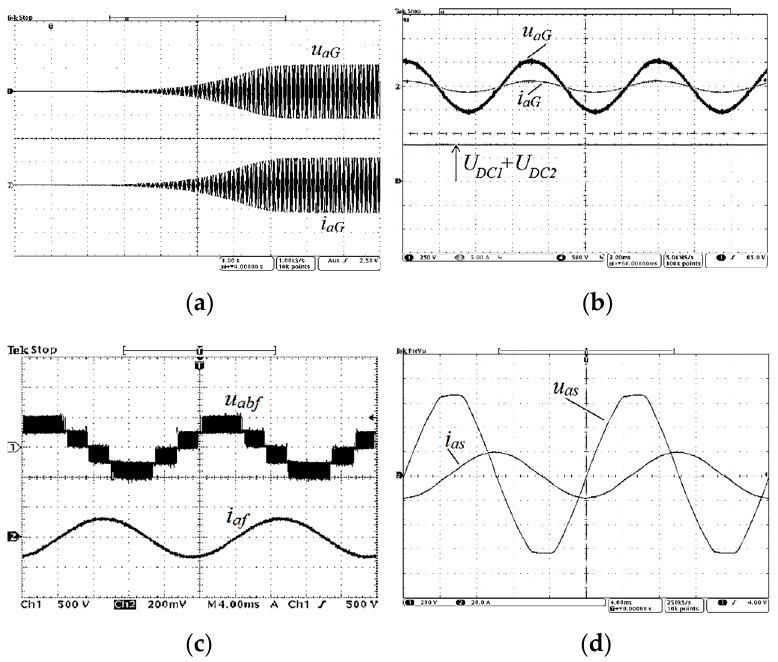
Figure 21. Selected experimental waveforms of voltage and current in the investigated generator system (Figure 9): ( a ) voltage and current of the induction machine during the start-up, ( b ) voltage and current of the induction generator, and DC link voltage at steady state, ( c ) output voltage and current of the grid inverter, ( d ) voltage and current of the power grid for reactive power.